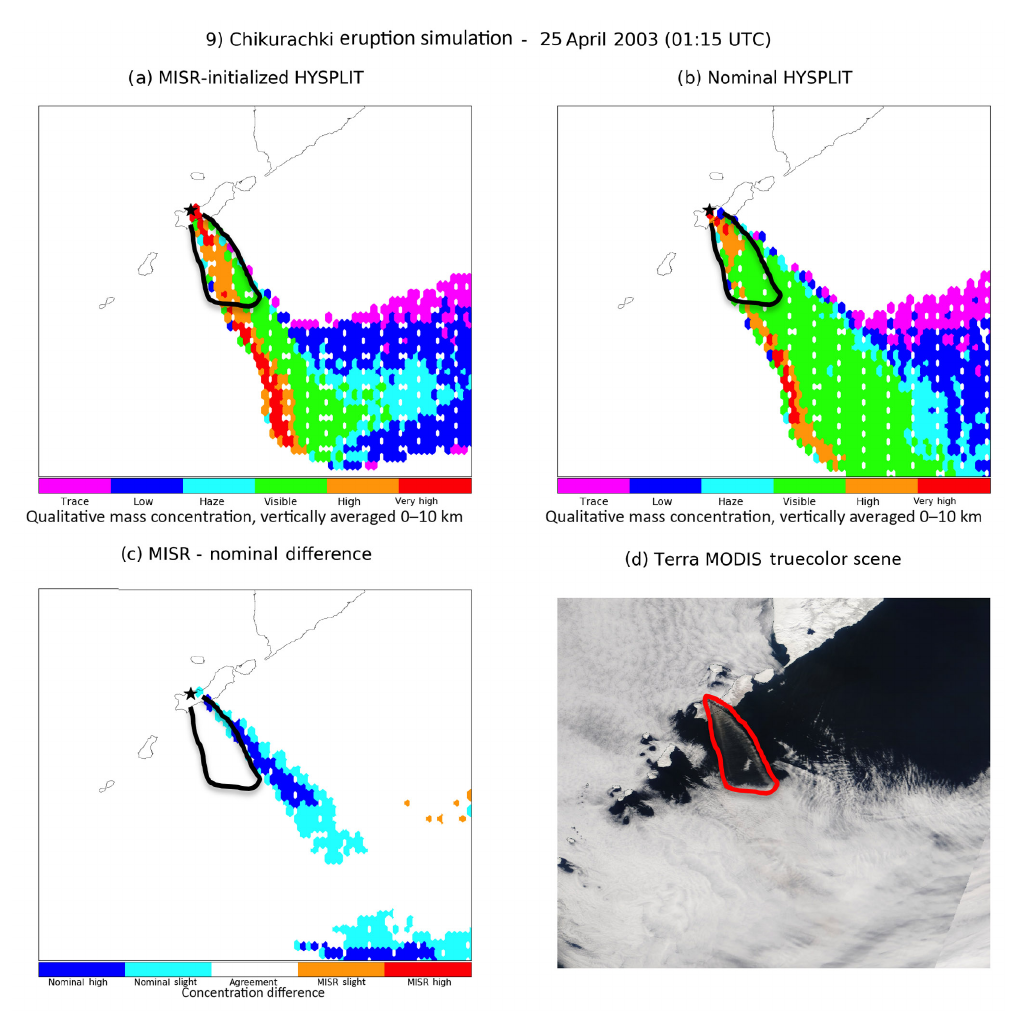
Figure 9. Same as Fig. 2, but for the Chikurachki volcanic eruption plume, on 25 April 2003. (a–b) Day 4 samplings of HYSPLIT 96h simulations that began on 21 April 2003, and (c) Day 4 difference plot. (d) MODIS true-color image acquired on 25 April